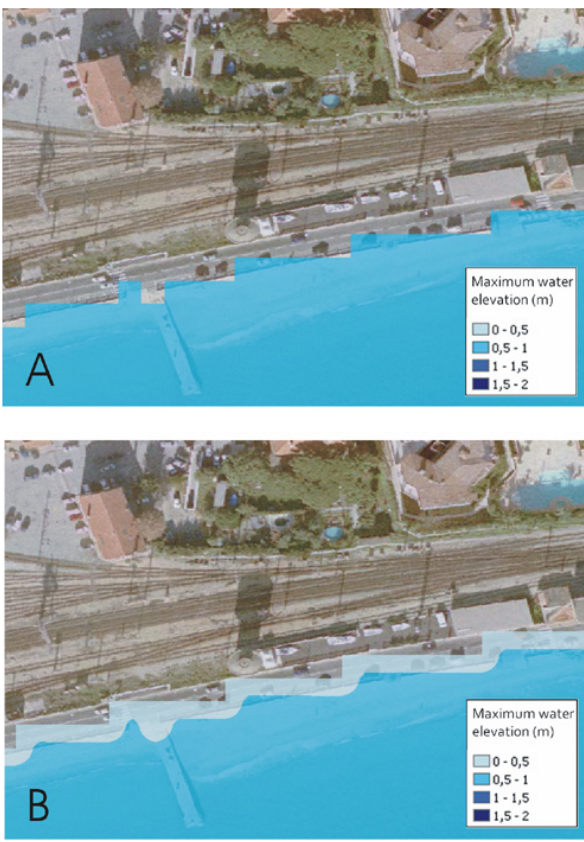
Fig. 6. (a) comparison between the DTM given as input to the nu- merical code COMCOT (Cornell University) and the DTM auto- matically resampled by the same code; (b) comparison between the vector and raster modelled water height (raster performed by Ar- cGIS package).